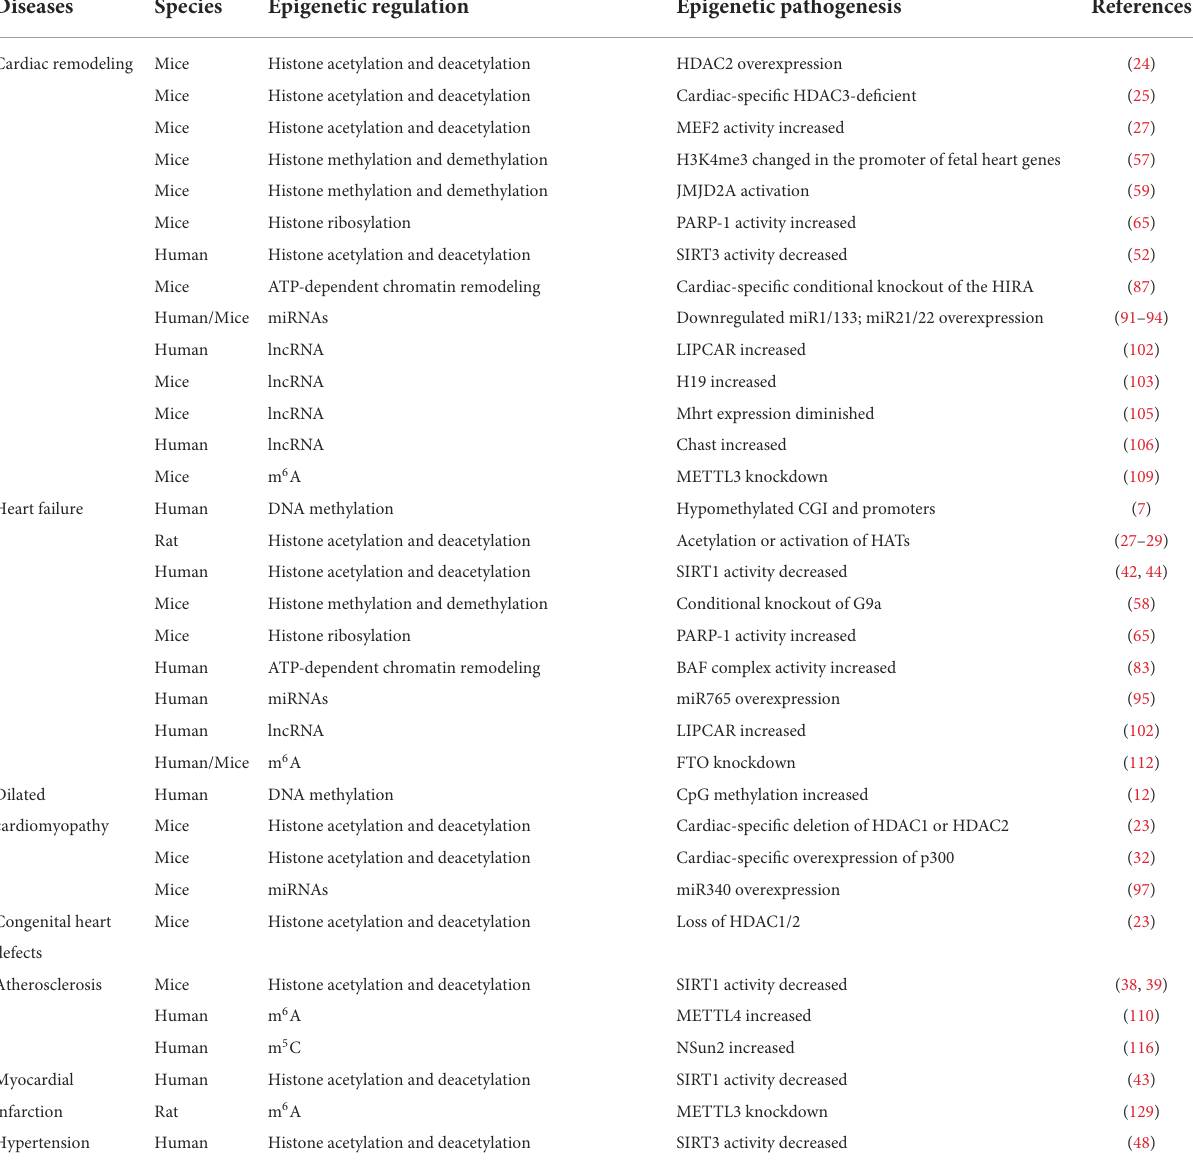
TABLE 2 The multiple cardiac diseases and their corresponding epigenetic pathogenesis.